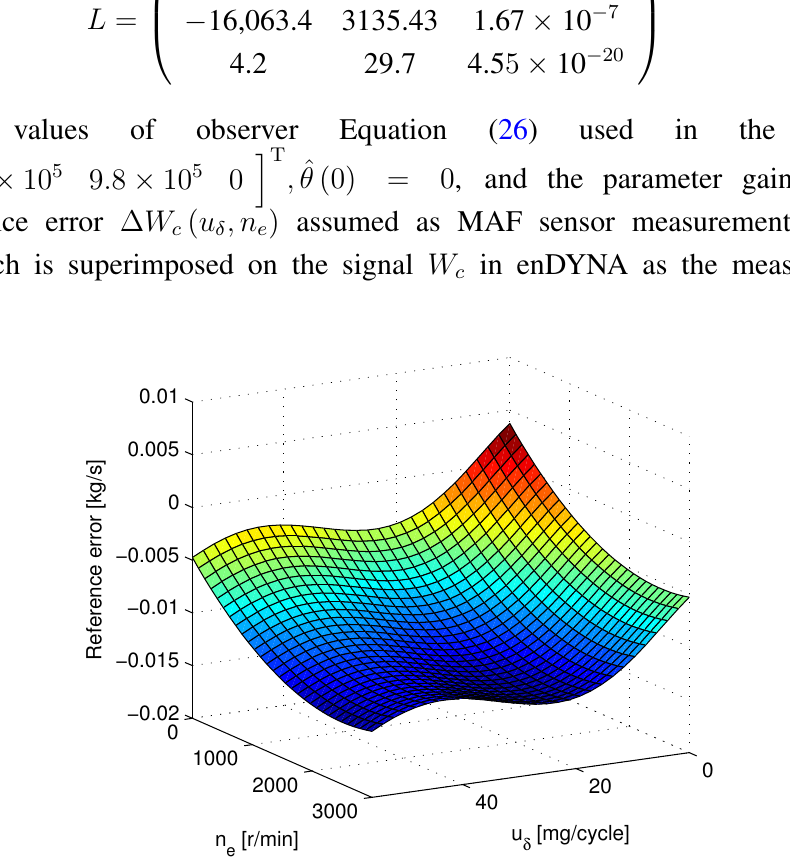
( u , n ) used as the mass air flow (MAF) sensor error c δ e